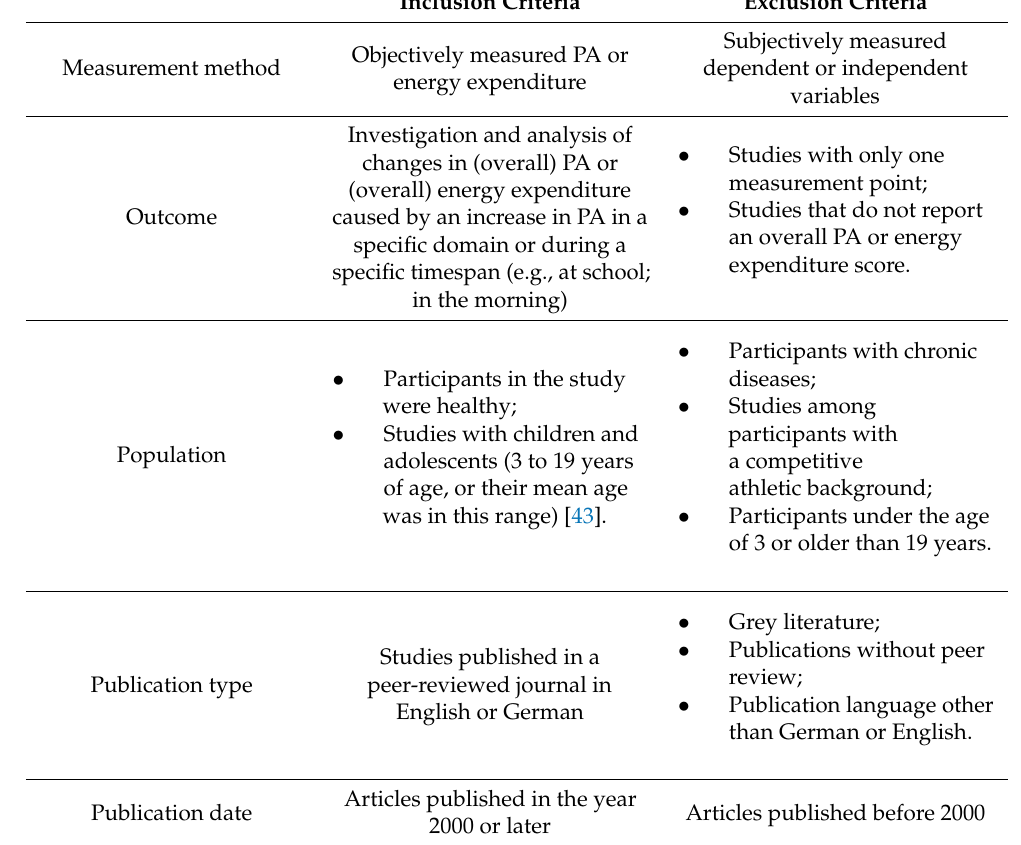
Table 1. Inclusion and exclusion criteria for the systematic review. Inclusion Criteria Exclusion